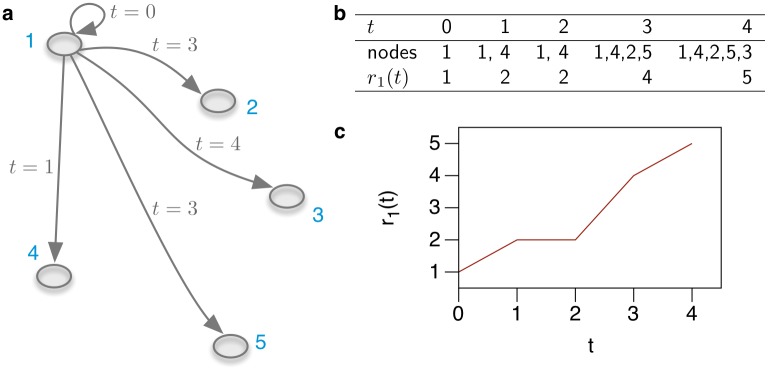
Unfolding accessibility for node 1 in the network shown in Fig 8.a Accessibility of node 1 including time stamps when nodes are accessed. b Number of infected nodes over time. c Infection curve (i.e. range) for source node 1.